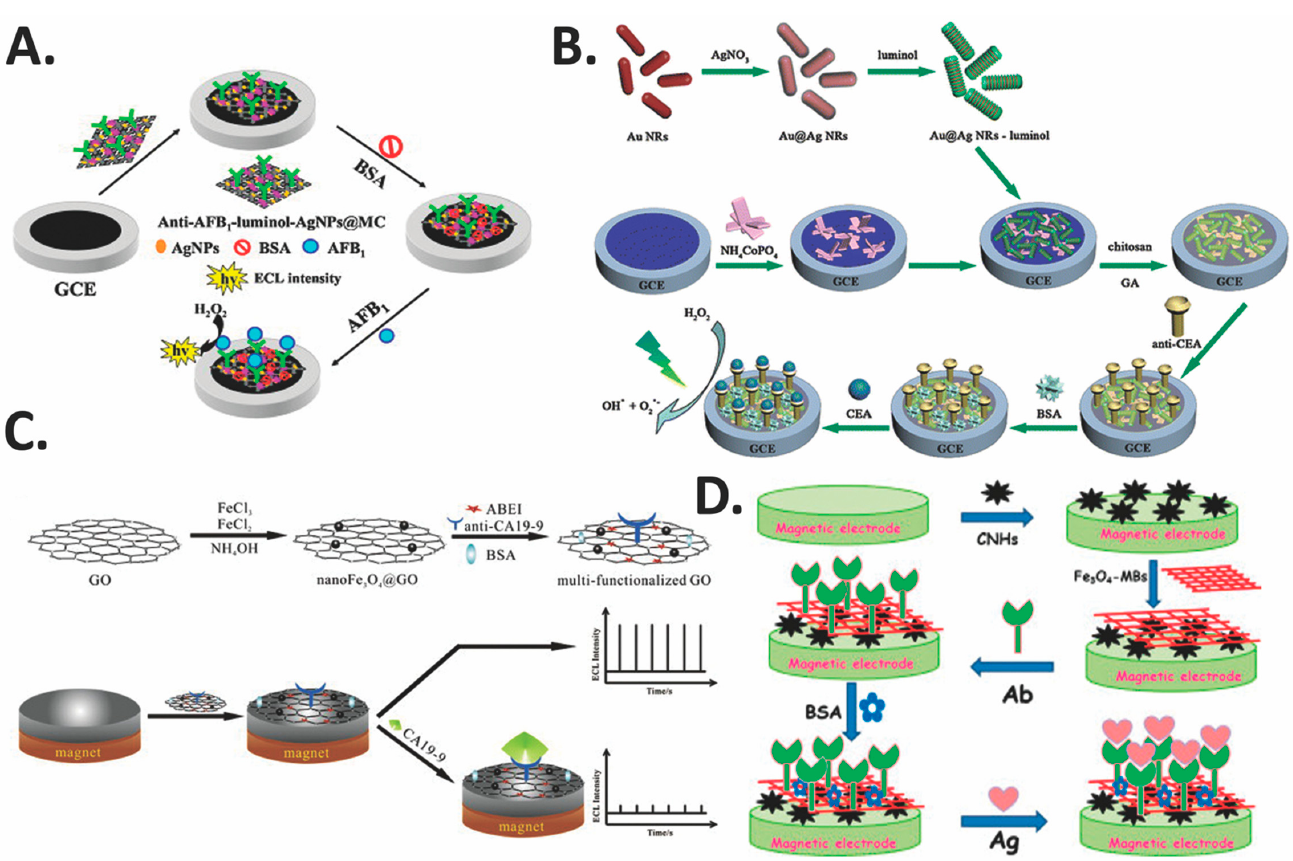
Figure 8. AgNPs nanocomposite-based ECL nanobiosensors: ( A ) ECL nanobiosensor with nanocomposite of luminol-AgNPs@OMC. Reprinted from Ref. [62] with permission from Elsevier; ( B ) ECL nanobiosensor with nanocomposite of NH 4 CoPO 4 /Au@Ag-luminol. Reprinted from Ref. [78] with permission from Springer; ( C ) ECL nanobiosensor with nanocomposite of nanoFe 3 O 4 @GO. Reprinted from Ref. [79] with permission from Elsevier; ( D ) ECL nanobiosensor with nanocomposite of Fe 3 O 4 -NFs. Reprinted from [81] with permission from Elsevier.